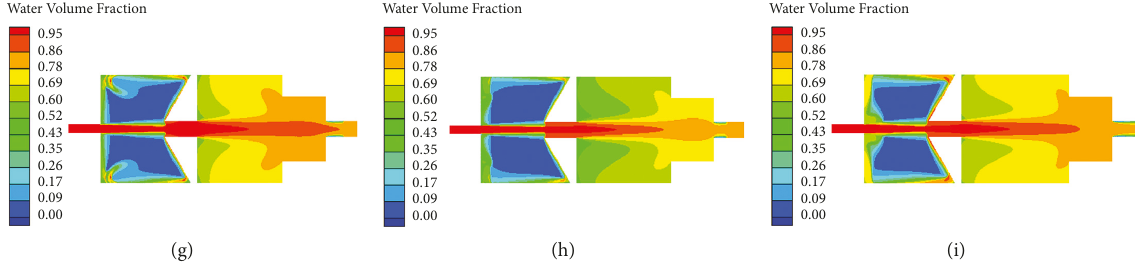
Figure 14: Cloud images of the water volume fraction distribution of dual-chamber self-excited oscillating pulsed nozzles. (a) D/a (b) D/a 3.33; (c) D/a (cid:28)